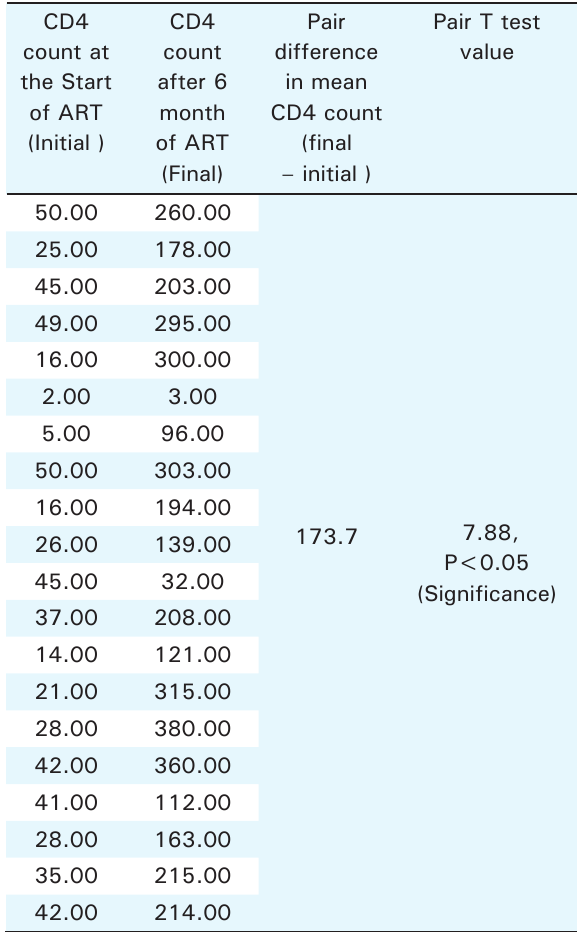
table 5. cD4 status of the patients before and